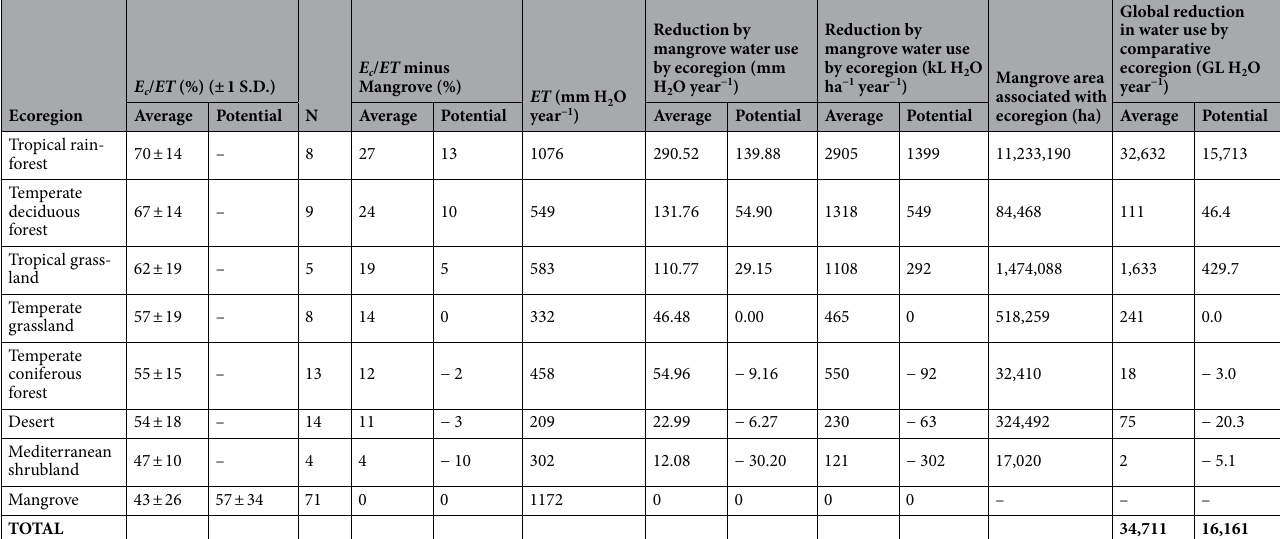
rates of water flux in the outer sapwood of trees. This result suggested that the velocity of xylem water ascent in mangroves may not be distinctively low, despite the environmental conditions under which mangroves develop. For example, median sap velocities of mangroves from outer sapwood locations averaged ~ 0.13 mm s −1 in Bor- neo and Hawaii, USA 35,36 , which did not differentiate strongly from median velocities of ~ 0.13–0.16 mm s −1 in adjacent upland tropical dipterocarp or heath forest trees 35 . However, volume of water flux in mangroves is low versus many terrestrial forest trees (Fig. 1b) because sap flow with depth into sapwood (from cambium beyond